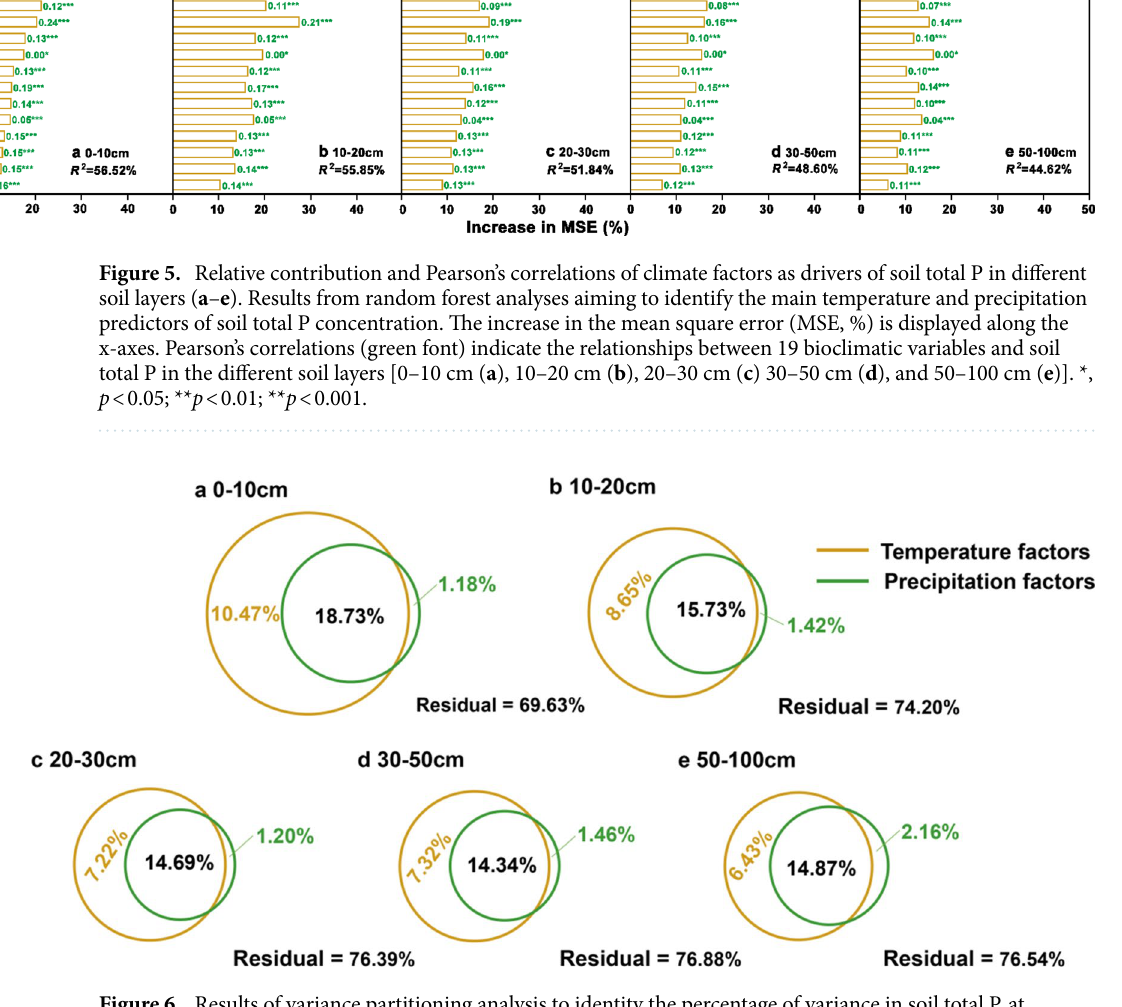
Figure 6. Results of variance partitioning analysis to identity the percentage of variance in soil total P, at different soil depths ( a – d ) explained by of temperature and precipitation in China’s forest ecosystems. The sizes of the circles indicate the relative contributions of the